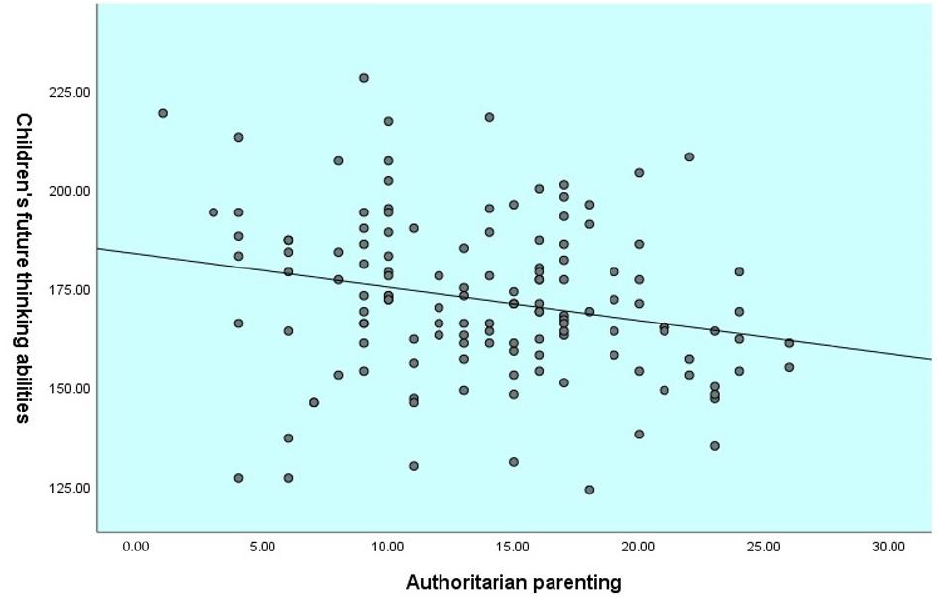
Figure 3. Correlation between authoritarian parenting and children’s future-oriented cognition total score. Table 3. Linear regression for parenting style predicting future-oriented cognition in